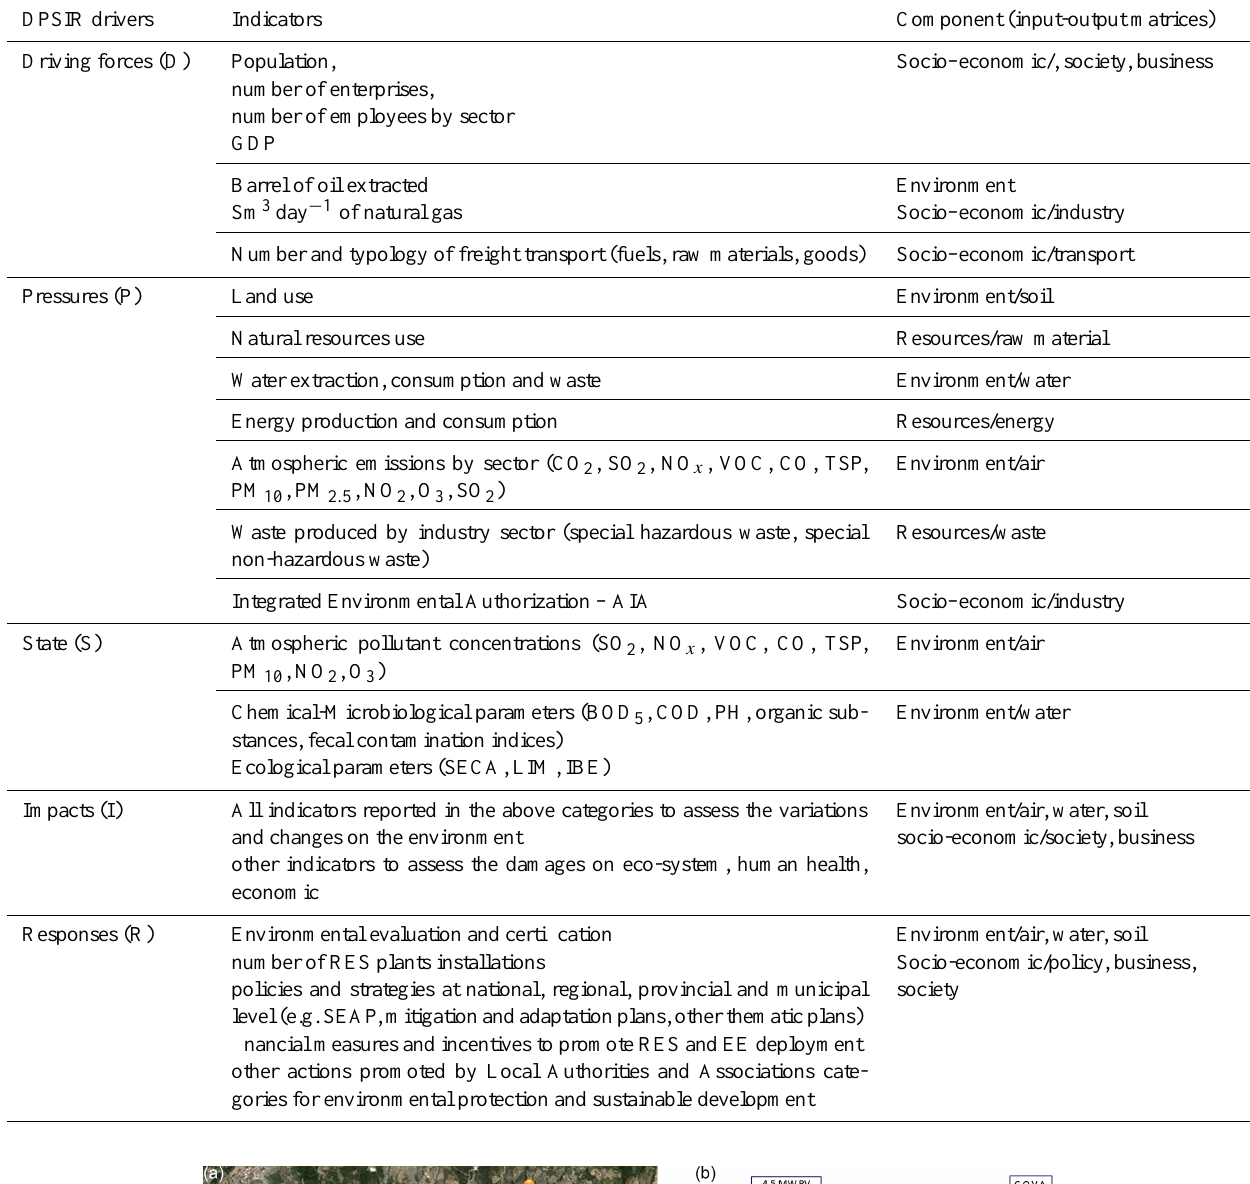
Table 1. Main indicators for the DPSIR of Alta Val d’Agri industrial area. DPSIR drivers